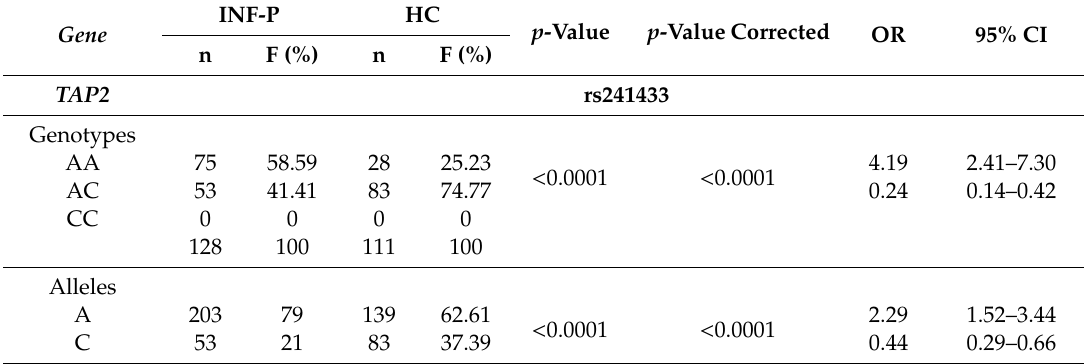
Table 2. Allele and genotype frequencies between cases and